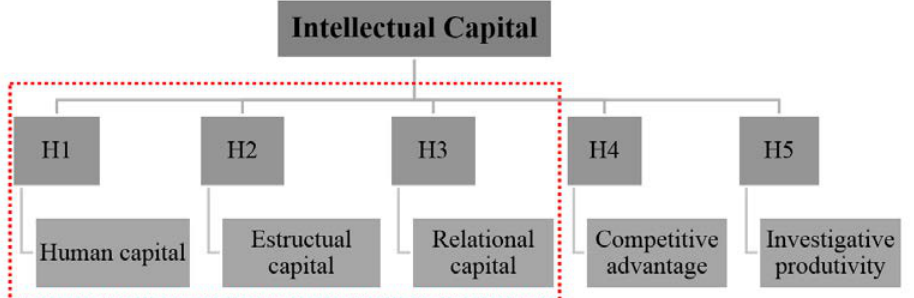
Figure 1. Intellectual capital